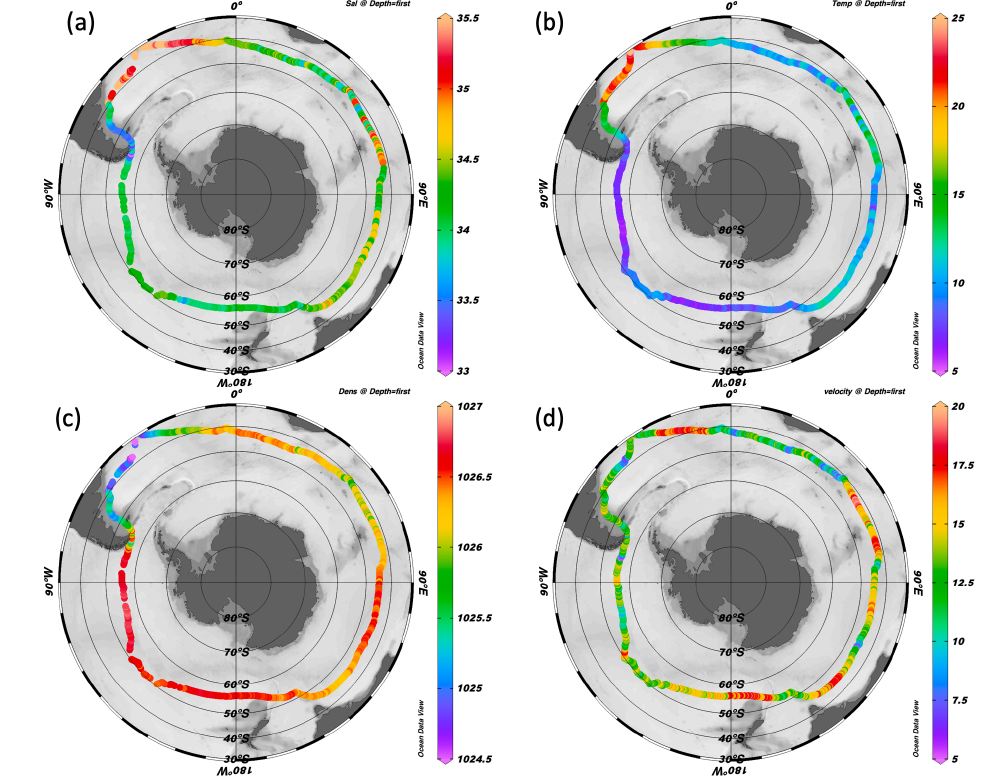
Figure 5. ( a ) Salinity (psu), ( b ) temperature ( ◦ C), ( c ) density (kg/m 3 ) and ( d ) velocity (knots) along the